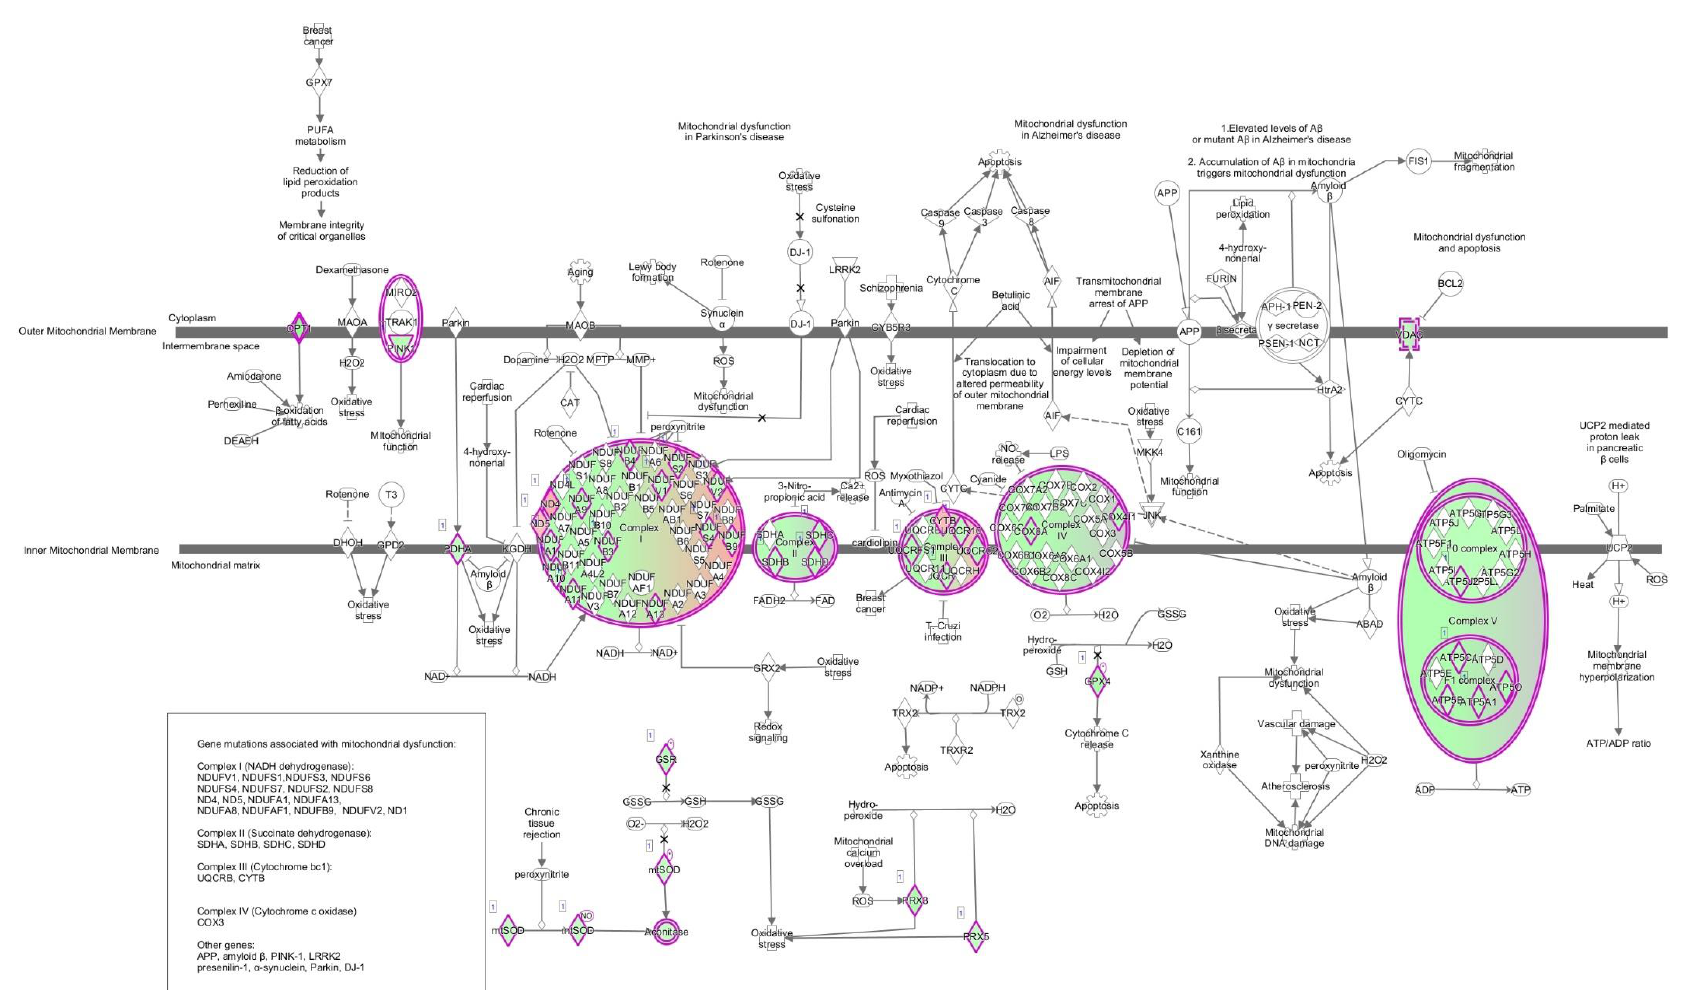
Figure 1. Data collected from transcriptomic and proteomic experiments were imported into IPA. One of the most prominent pathways seen in one-month 16 O-irradiated C57BL/6 mice livers in the transcriptomic data was mitochondrial dysfunction. 46 transcripts in this pathway were dysregulated as compared with the non-irradiated control. Green indicates down regulation and red indicates up regulation. The brighter the color, the more extreme the altered